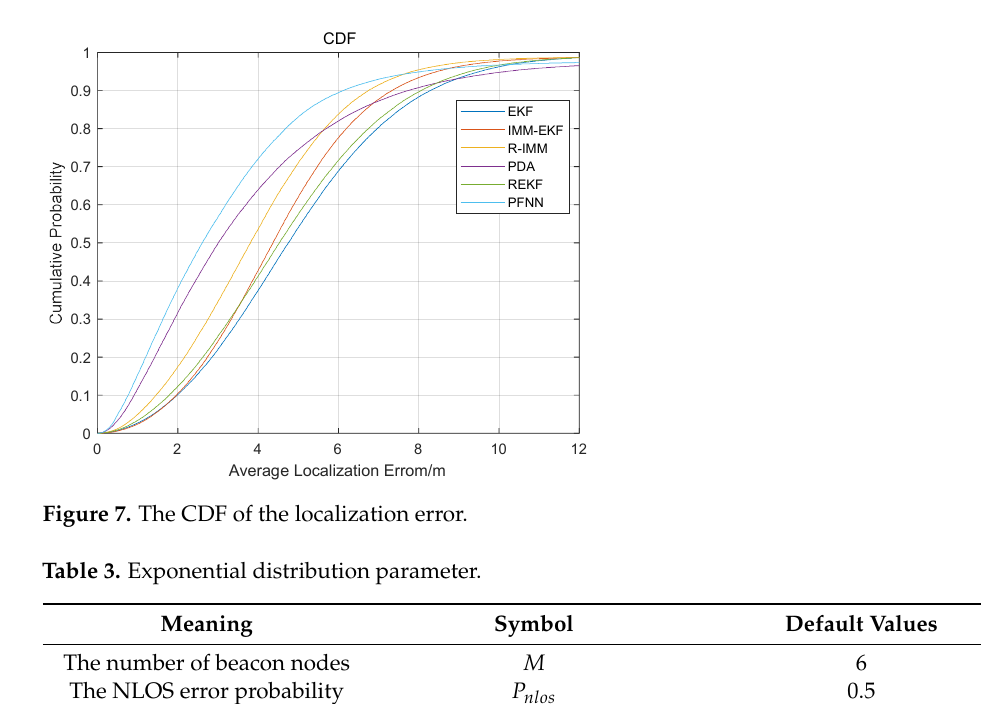
Figure 6. The RMSE versus the parameter max in the NLOS error.